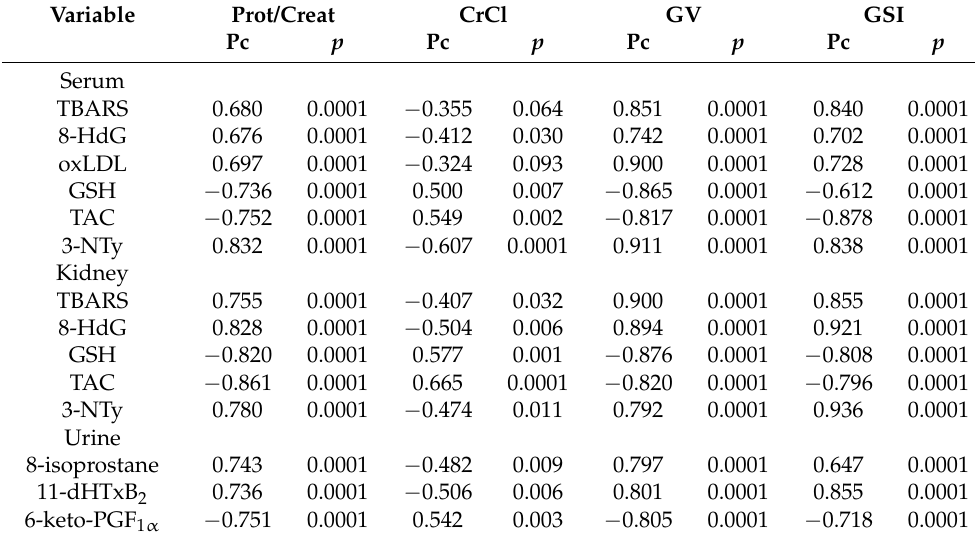
Table 4. Statistical Pearson correlations between the glomerular volume (GV), glomerulosclerosis index (GSI), creatinine clearance (CrCl), and the proteinuria/urine creatinine ratio (Prot/Create) with the biochemical variables in serum, kidney, and